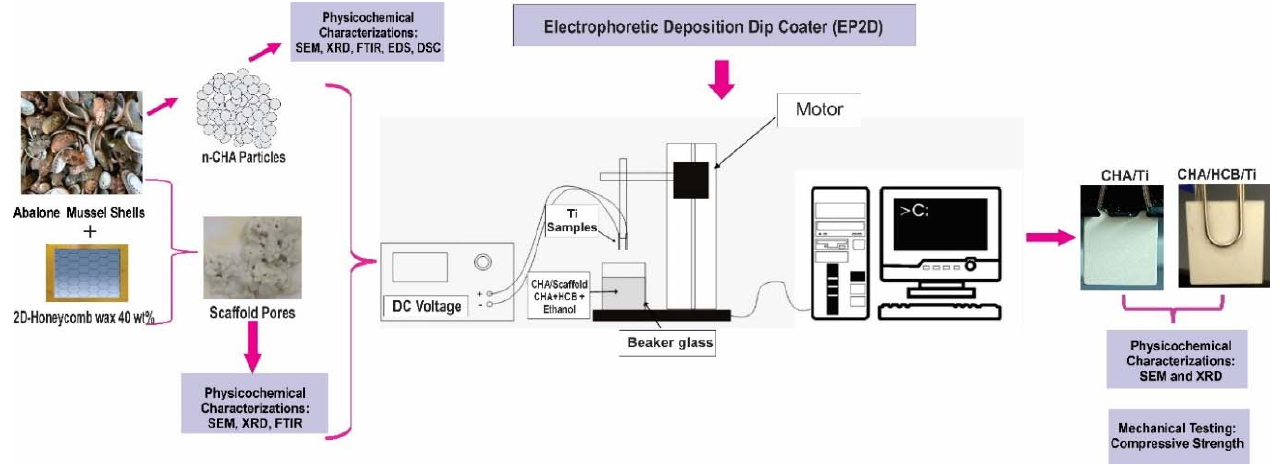
Figure 1. Schematic of methods used for CHA/Ti and CHA/HCB/Ti coatings procedures.